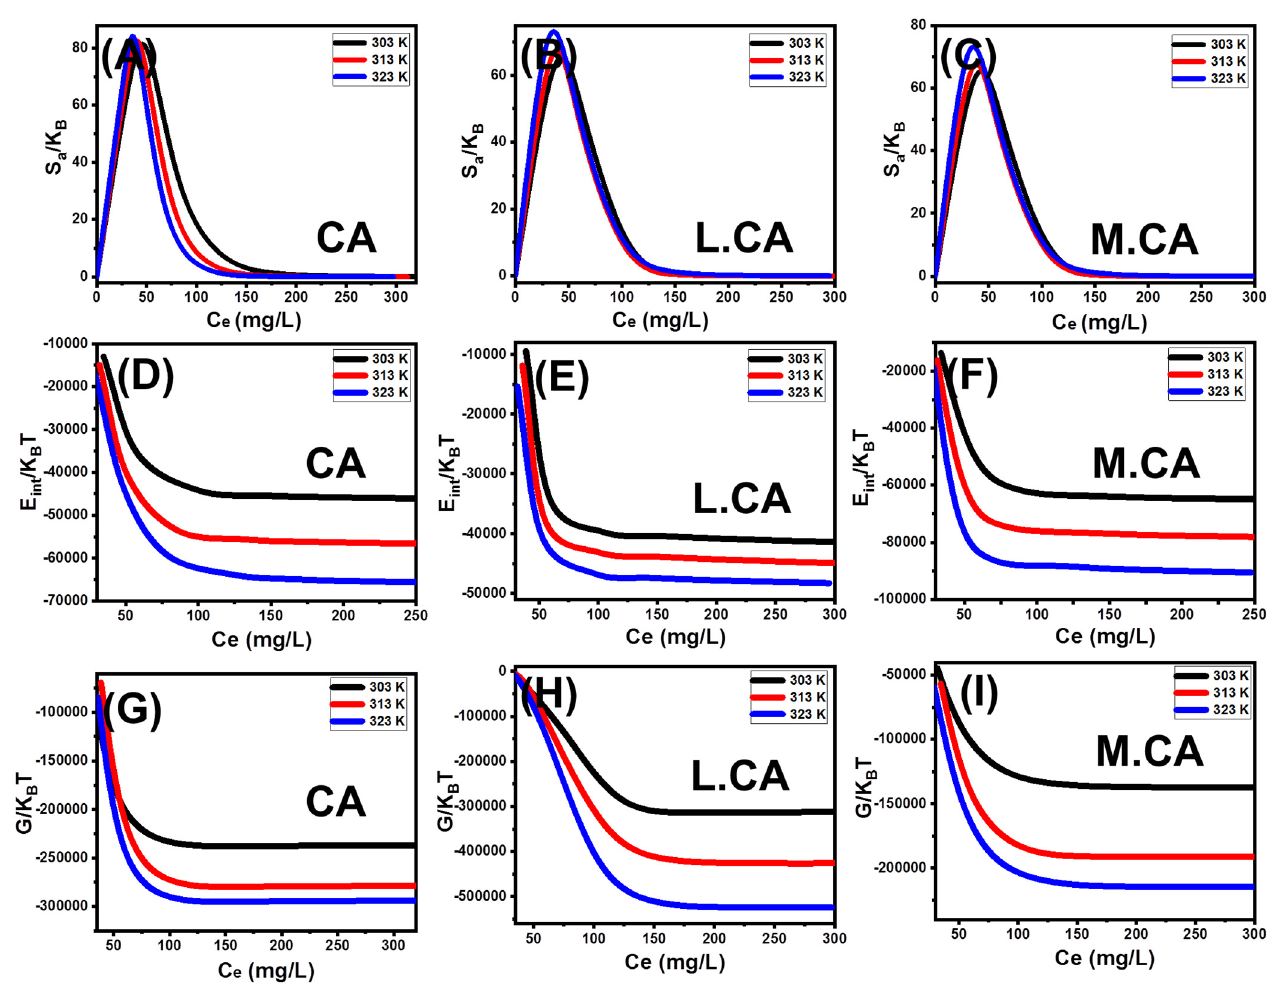
Figure 7. The change in the entropy properties of the Zn (II) retention processes by the calcite samples ( A – C ), the change in the internal energy properties of the Zn (II) retention processes by the calcite samples ( D – F ), and the change in the free enthalpy properties of the Zn (II) retention processes by the calcite samples ( G – I ).